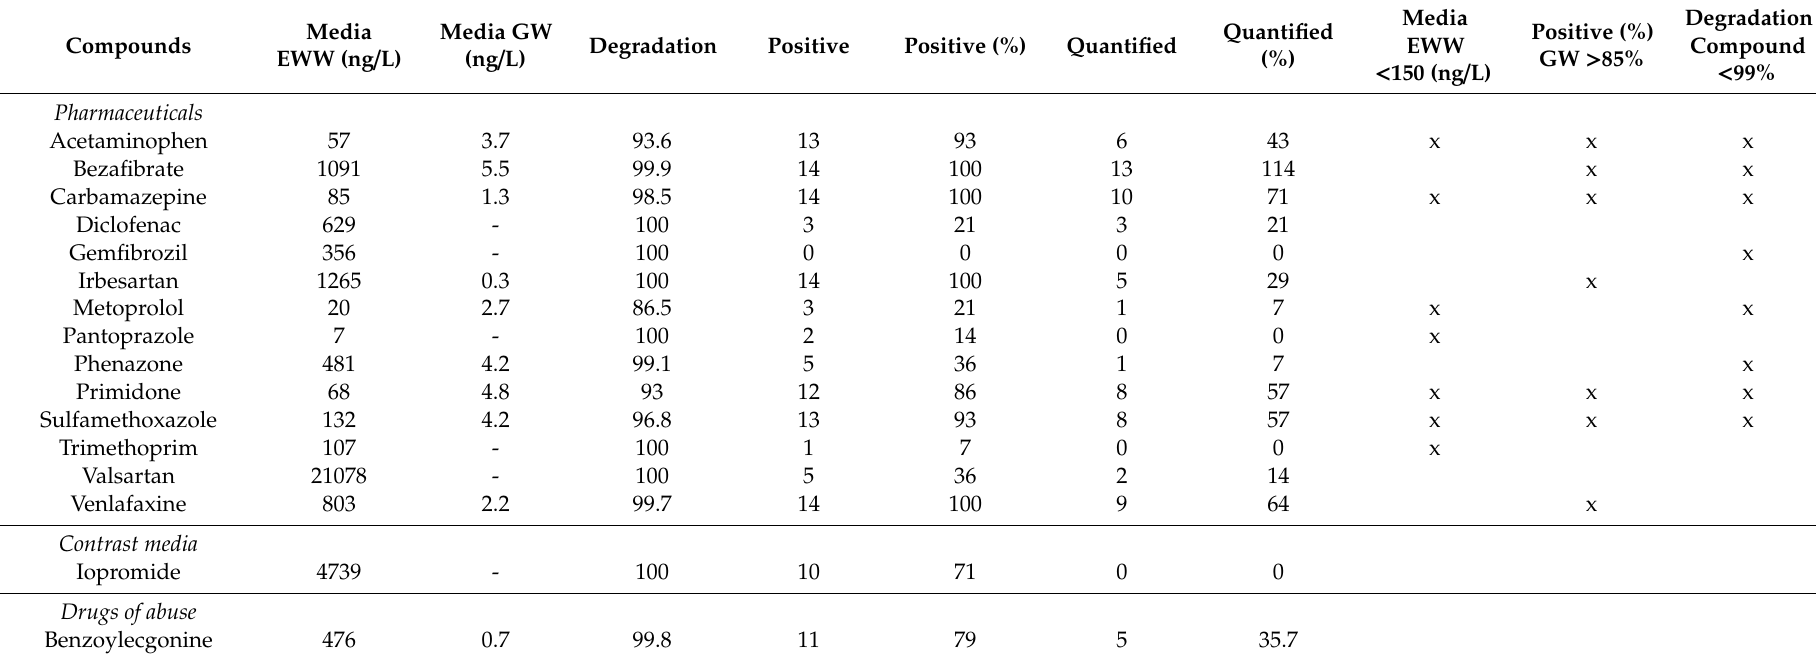
Table 4. Percentage of degradation during the trajectory from the WWTP to the